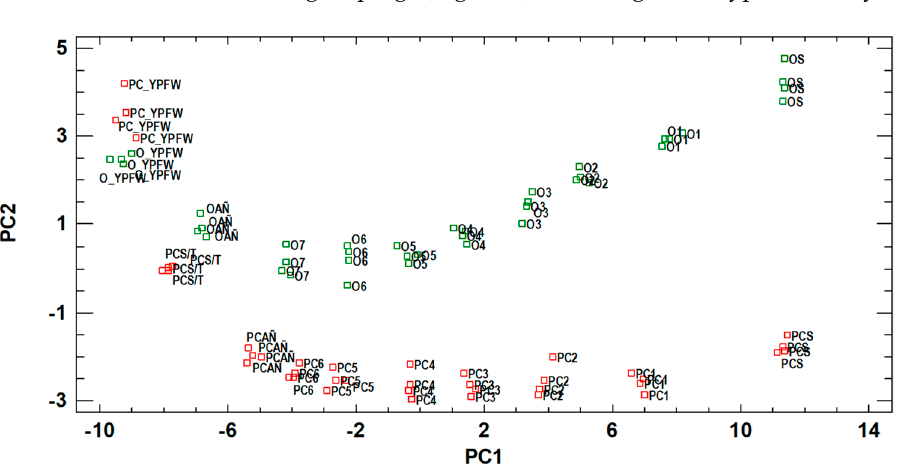
Mean values ± standard deviation ( n = 4) are shown; ANOVA: for the same wine, different letters (a, b, c, d, e, f, g, h, i, j) indicate significant differences ( p < 0.05). Y.P.F.W.: Young Palomino fortified wine; Cra: Criadera; S/T W. *: selected S/T wines for Palo Cortado; S/T: Sobretabla .